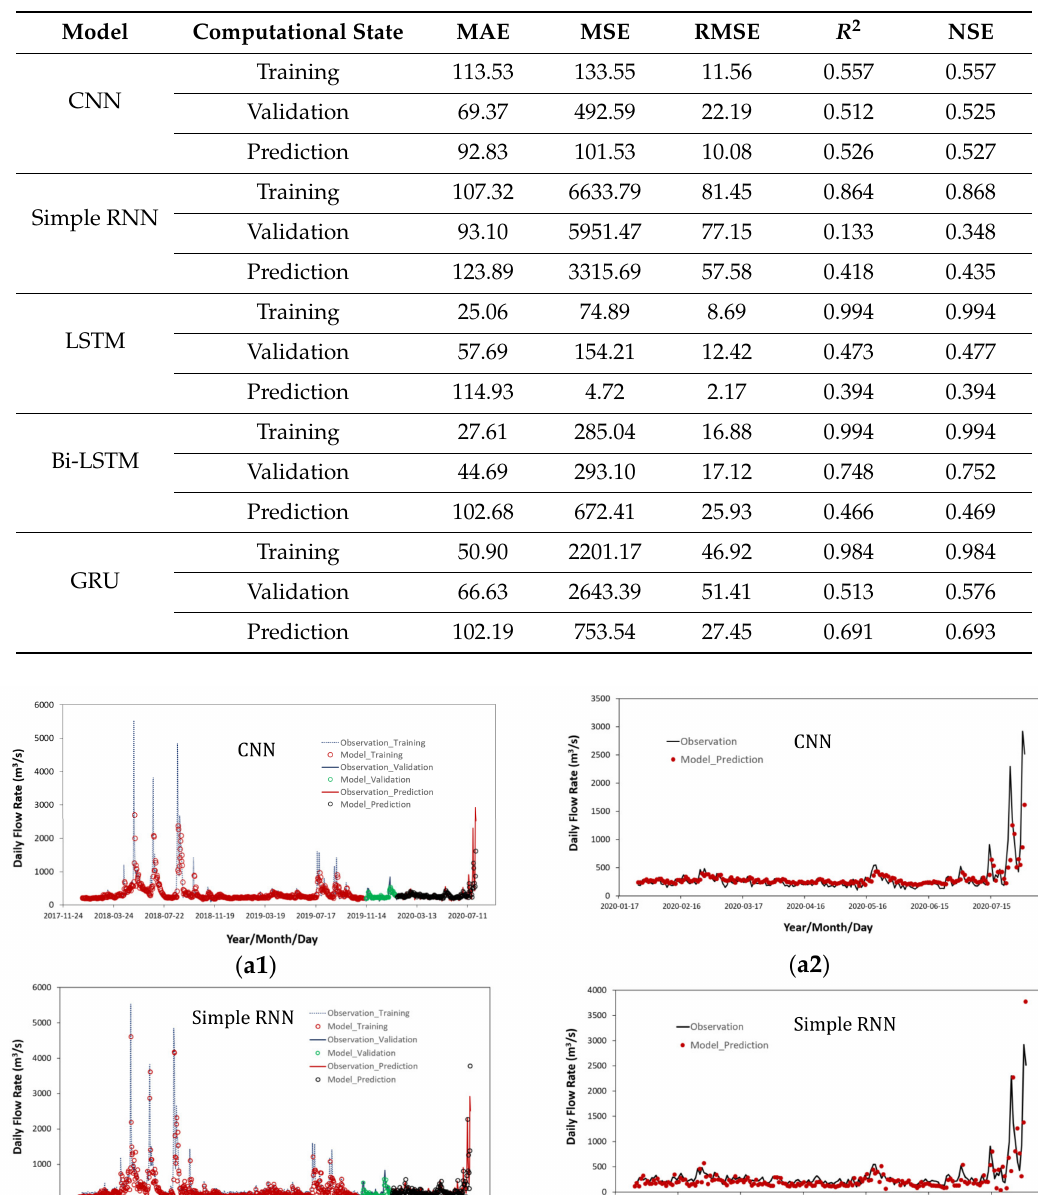
Table 5. Performance comparison of models.